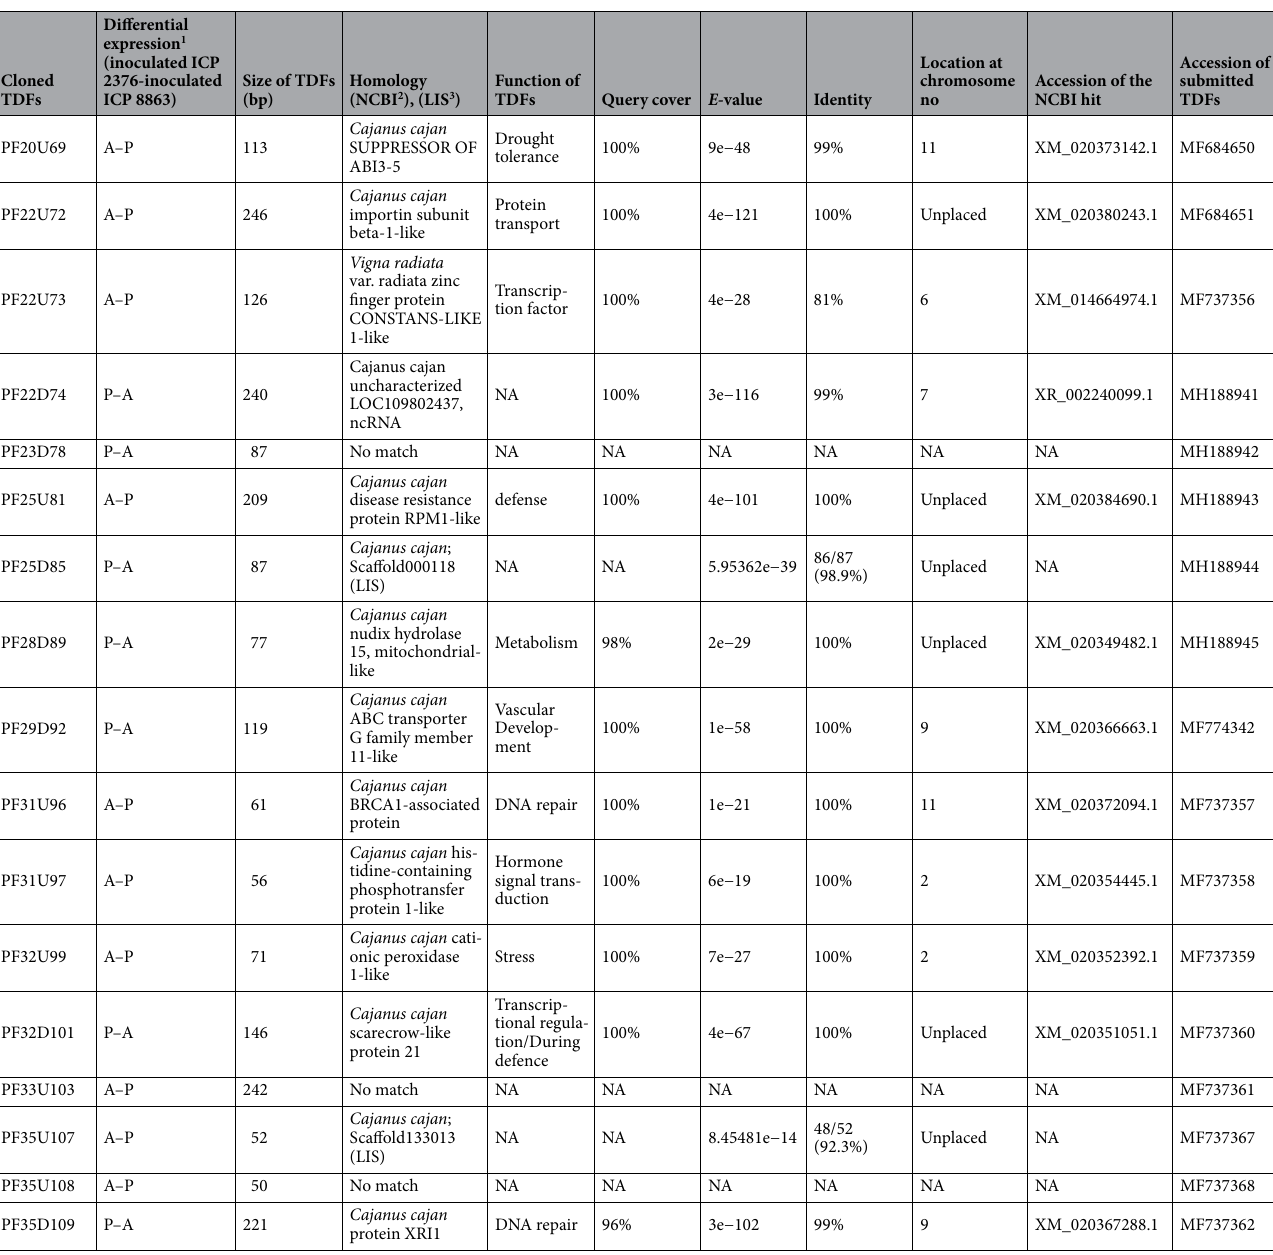
Table 1. Differentially expressed pathogen induced transcript derived fragments (TDFs) revealed by BLASTN search. 1 A refers to down-regulation and P refers to up-regulation, 2 NCBI National Center for Biotechnology Information, 3 LIS Legume Information System, 4 NA not